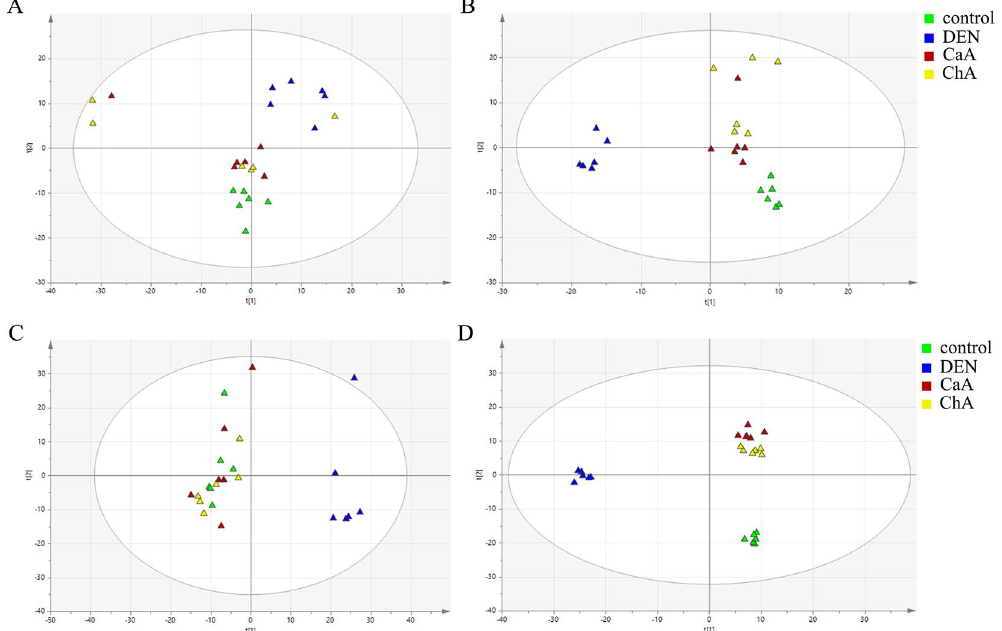
Figure 6. PCA and PSL-DA score scatter plots show metabolic pattern among control, DEN, DEN + CaA and DEN + ChA group. ( A ) PCA and ( B ) PLS-DA score plot conducted by GC-MS data (R2Y = 0.952, Q2 = 0.411). ( C ) PCA and ( D ) PLS-DA score plot conducted by HPLC-MS data (R2Y = 0.995, Q2 =